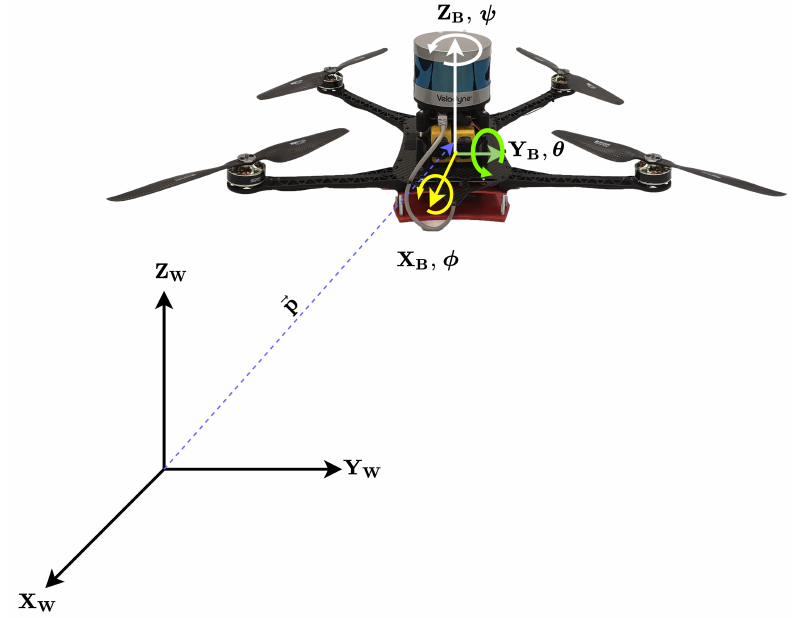
Figure 2. Co-ordinate frames: subscript W denotes the global frame and subscript B denotes the body